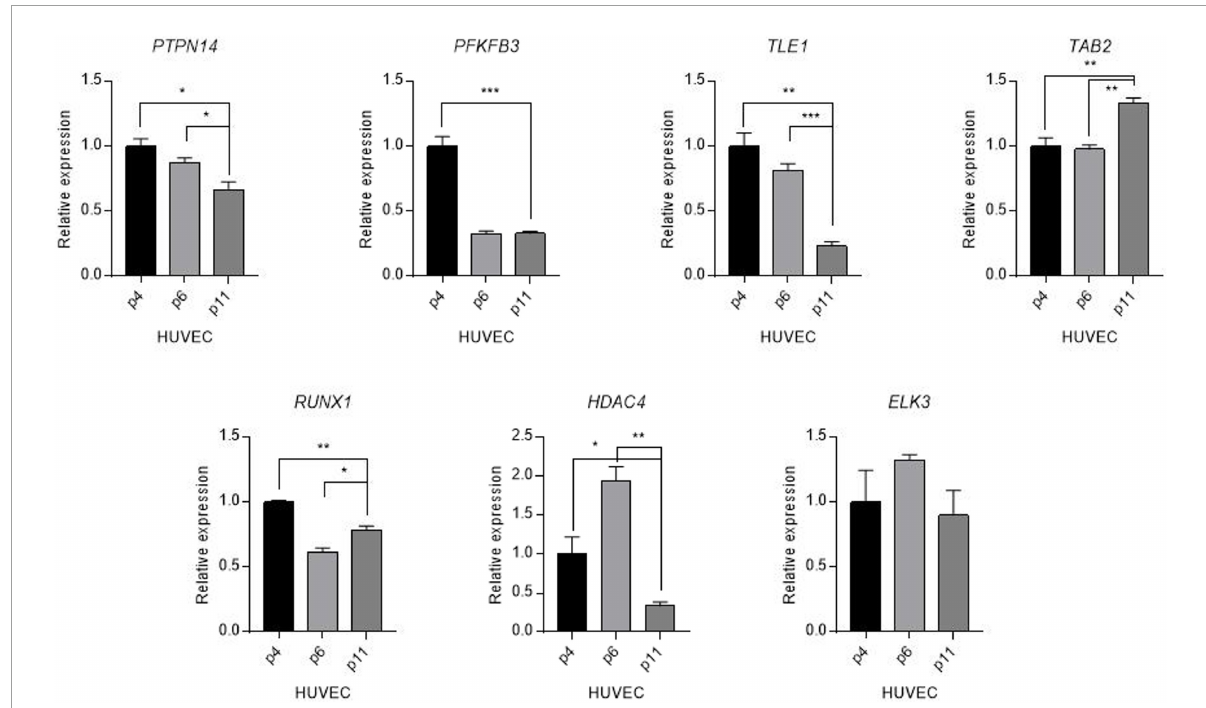
FIGURE3 Differential expression of candidate genes in aged human vascular endothelium cells (HUVEC). Expression levels of candidate genes were quantified by using a real-time polymerase reaction chain (PCR) in human umbilical vein endothelial cells (HUVECs) of varying passages: young (p4), middle (p6), and old (p11). Values are presented as mean SEM. * p < 0.05, ** p < 0.01, *** p < 0.001, n.s., not significant.